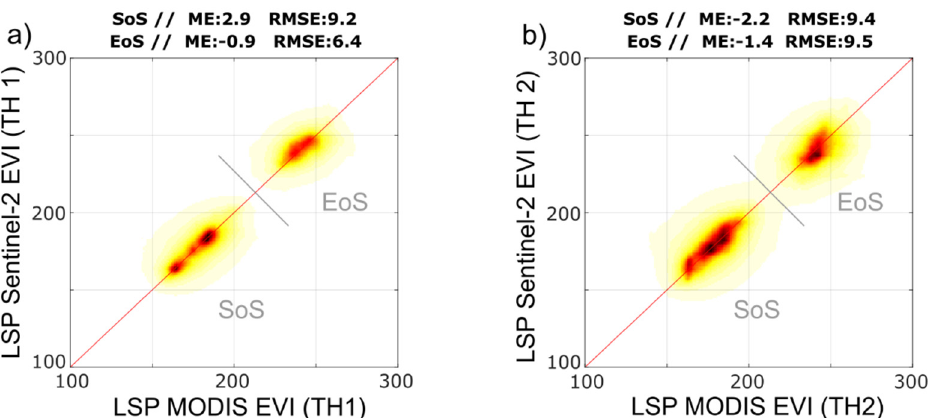
Figure 6. Comparison of the phenology metrics, start of season (SoS) and end of season (EoS), estimated with Sentinel-2 and MODIS (MOD09GAv6) time series using the threshold method without ( a ) and with ( b ) data smoothing. The bias between PhenoCam and Sentinel-2 is reported with the mean error (ME) and the accuracy with the root mean squared error (RMSE).